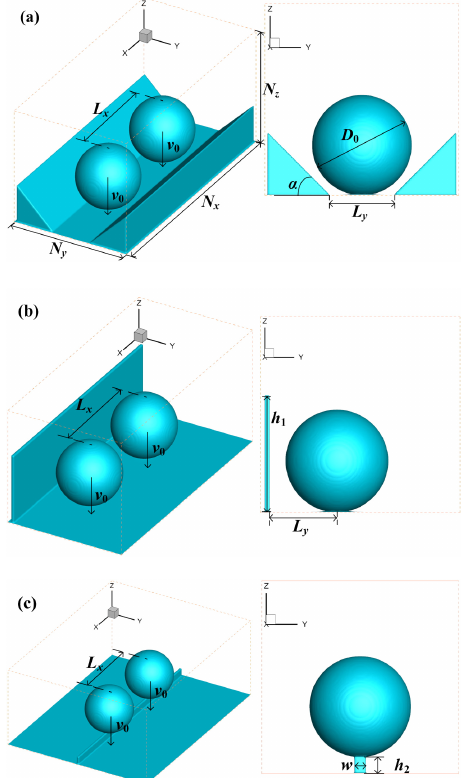
Figure 2. Schematics of two droplets simultaneously impacting superhydrophobic surfaces with three different macrotextures. ( a ) The S1 surface. ( b ) The S2 surface. ( c ) The S3 surface.